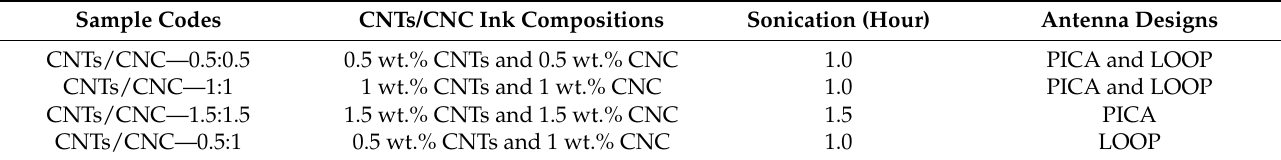
Table 1. CNTs/CNC ink compositions with related sample codes and printed antenna